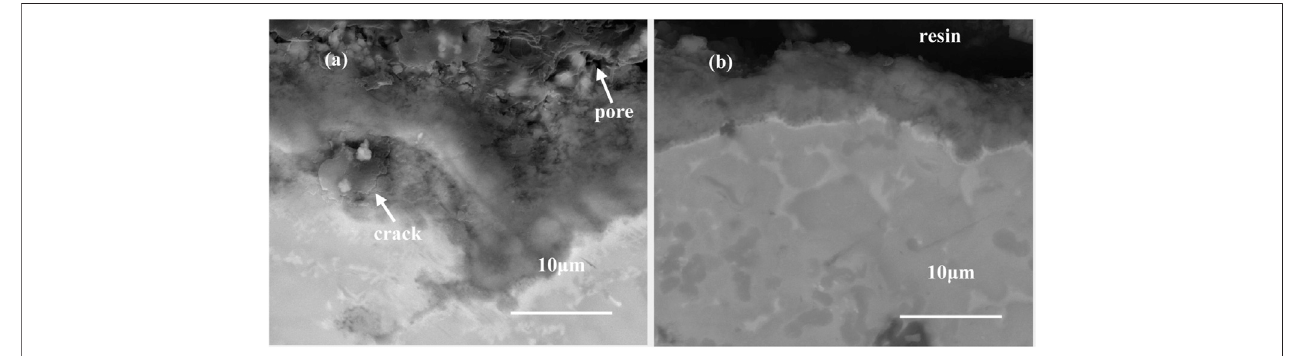
FIGURE10| Cross-sectionalmorphologiesoftheoxide fi lmsonthecoatingscontaining (A) 0wt%Sm 2 O 3 and (B) 3wt%Sm 2 O 3 afteroxidationat900 ° Cfor100 h.